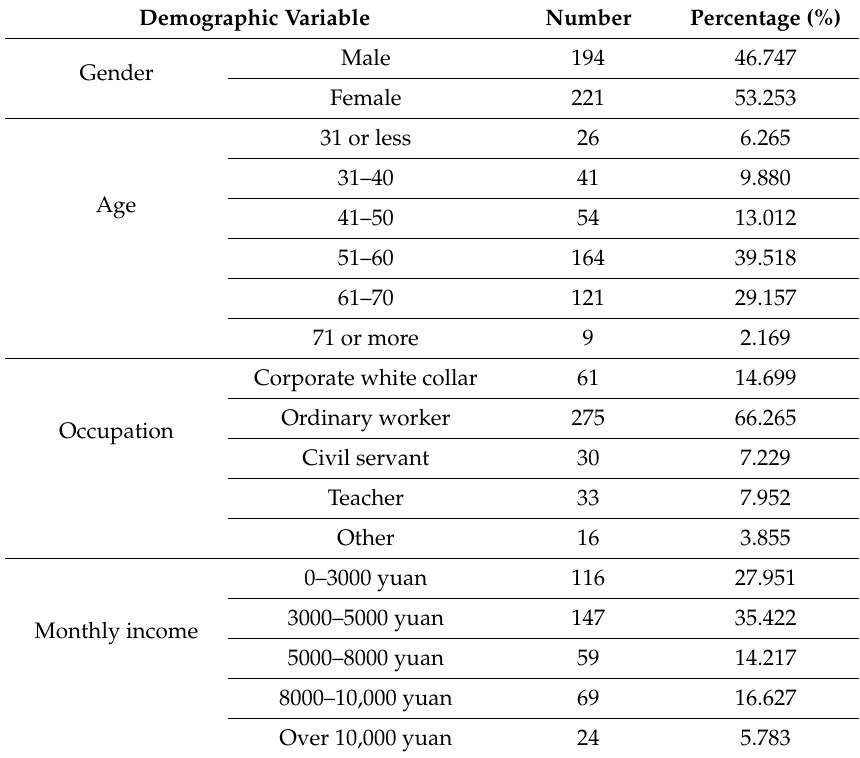
Table 2. Demographic